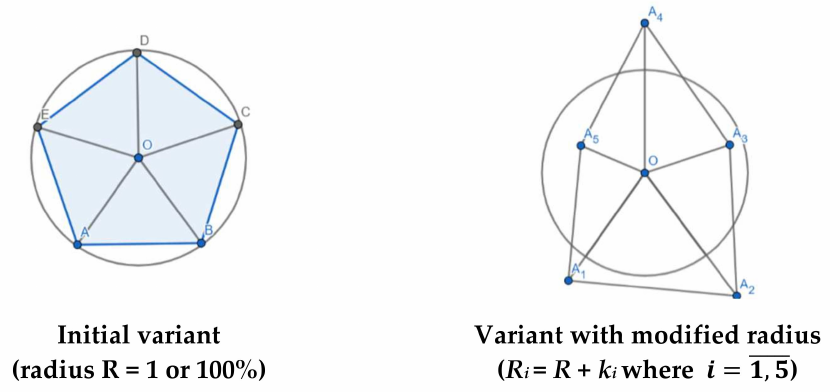
Figure 4. MID-specific dual graphics in “ 5-gon ”